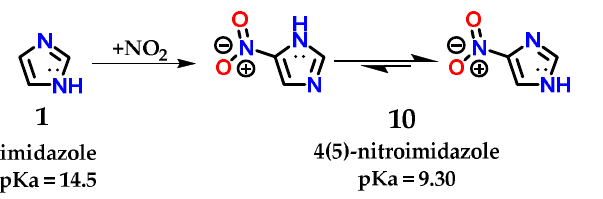
Figure 7. Representation of imidazole 1 and tautomeric forms of 4(5)-nitroimidazole 10 , with their respective pKa values.